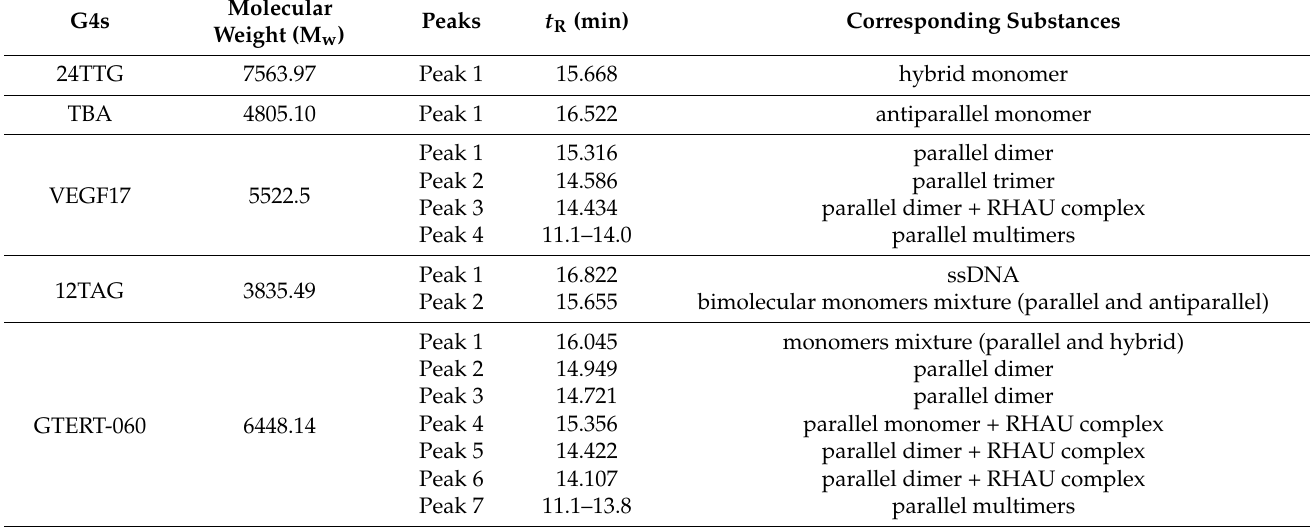
Table 1. Chromatographic peaks assignments of studied G4s presented in Figure